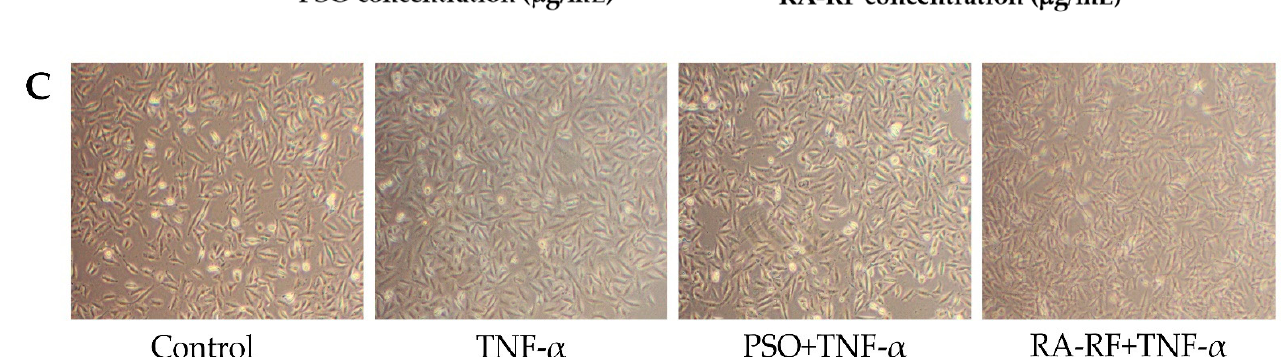
Figure 2. Effect of PSO and RA-RF on A549 cell viability. The cells were pre-incubated with PSO ( A ) or RA-RF ( B ) for 2 h and then treated with or without 100 ng/mL of TNF- α for 24 h. All assays were performed in triplicate; the data are presented as mean ± standard deviation. Morphology of A549 cells treated with 0.5% DMSO, 100 ng/mL of TNF- α , PSO (400 µg/mL) + TNF- α (100 ng/mL), and RA-RF (40 µg/mL) + TNF- α (100 ng/mL) ( C ) observed under inverted phase contrast microscopy (100× total magnification).